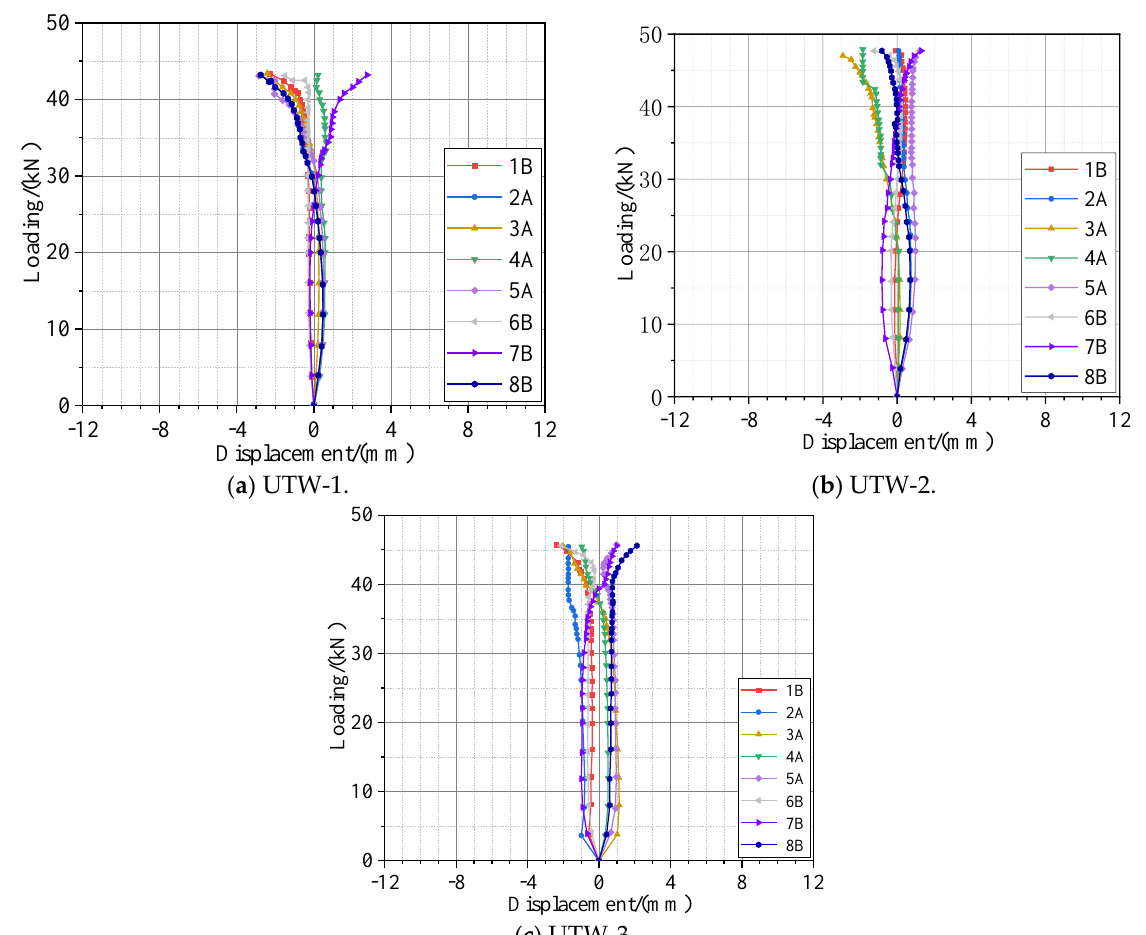
Figure 19. Loading−displacement curves of specimens in group 4. Figure 19. Loading-displacement curves of specimens in group